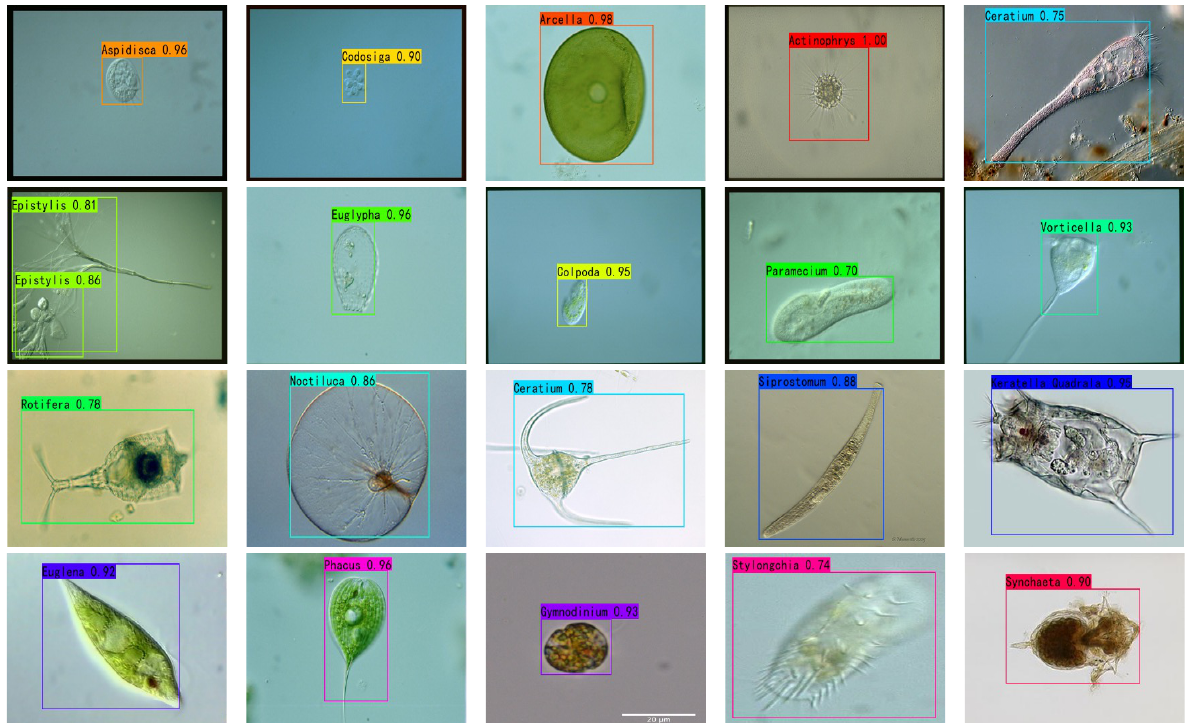
Figure 12. The detection results of SEM-RCNN on EMDS-6. The color boxes indicate the positions predicted by SEM-RCNN, for which its captions indicate the predicted categories and the probabilities.